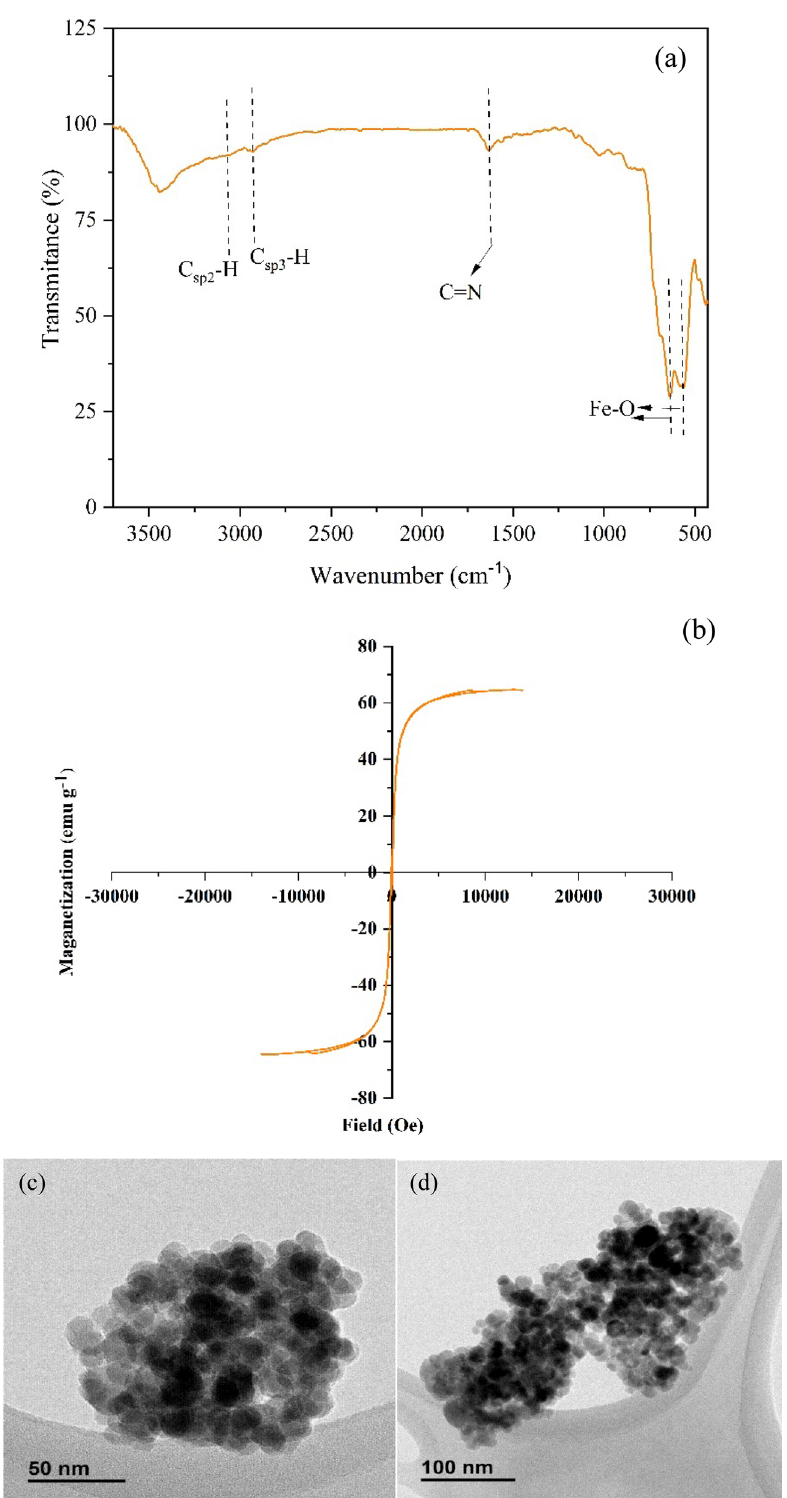
Figure 20. ( a ) FT-IR spectrum ( b ) VSM curve and (c,d) TEM images of (γ-Fe 2 O 3 -Im-Py) 2 WO 4 after 5th run reuse in the synthesis of 2-amino-3-cyano-4 H -chromenes via multicomponent